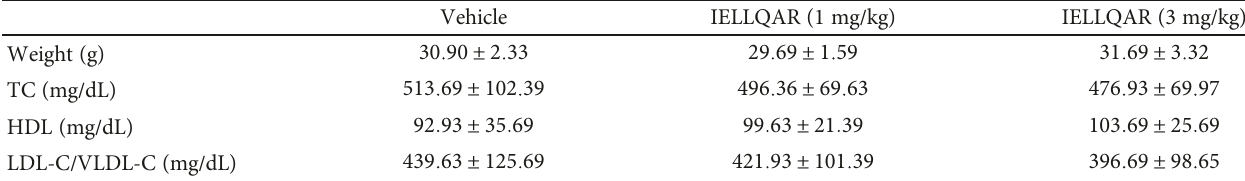
Table 2: Intervention e ff ects on lipid fractions in ApoE -/- mice.